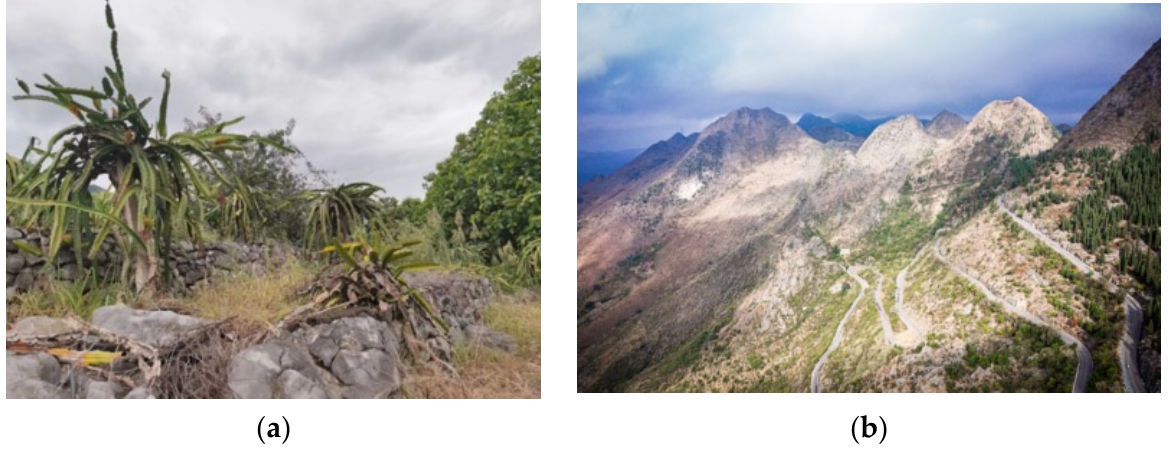
Figure 6. ( a ) Degradation of vegetation in karst desertification; ( b ) karst rocky desert